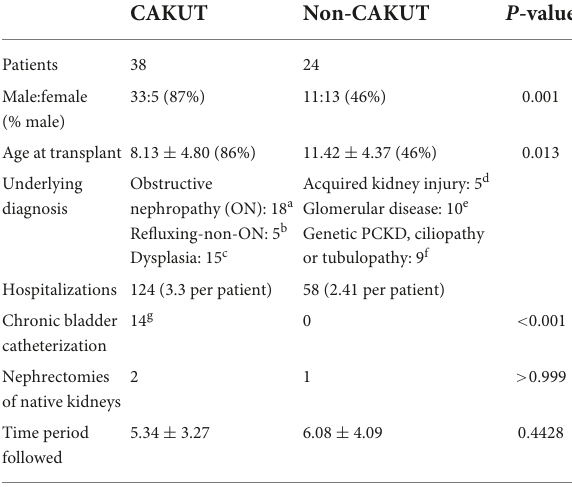
TABLE 1 Patient demographics and background.